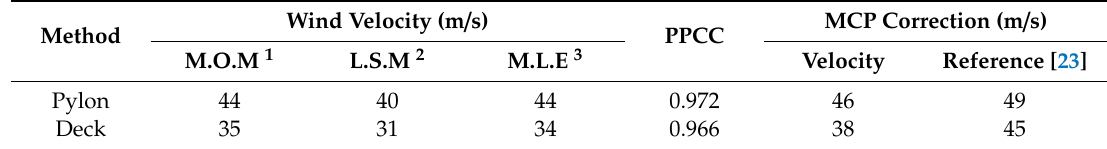
Table 2. Estimated Wind Velocity for a Recurrence Interval of